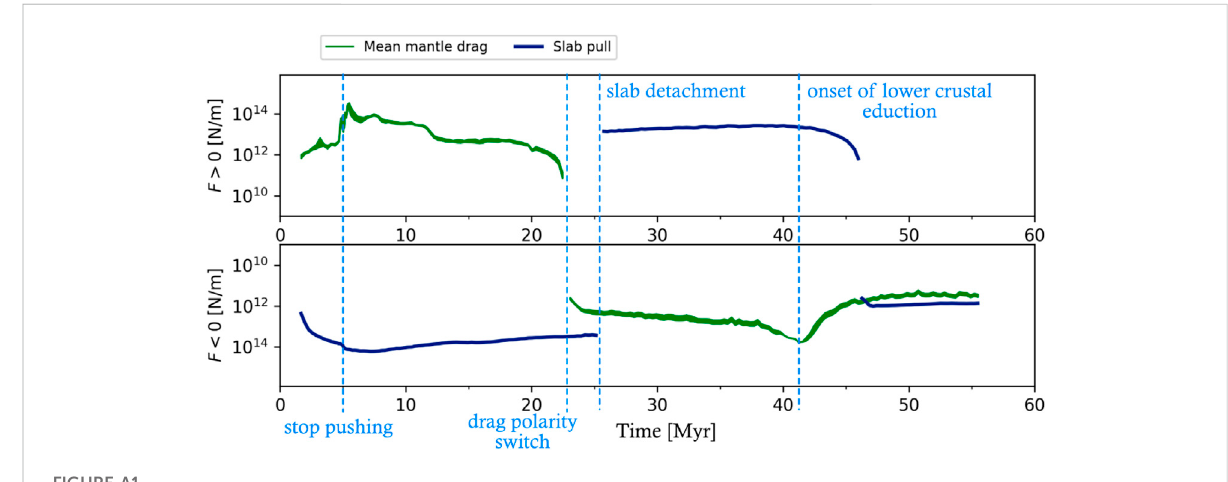
FIGURE A1 recycling of Figure 6B as a guide to the